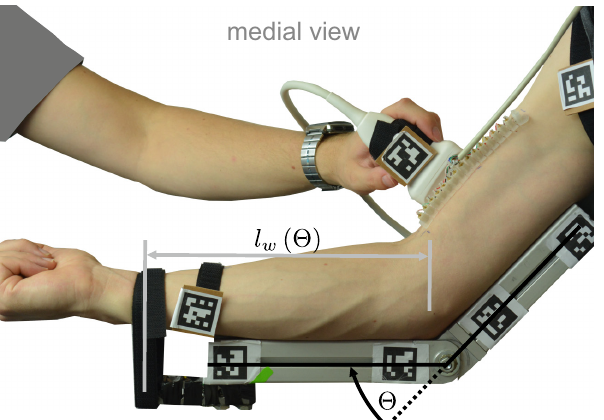
Fig 3. A medial view on the experimental setup. The distance l ( Θ ) between the elbow and the wrist strap, which w mechanically connects wrist and load cell, is marked with gray lines. The distance l w depends on the elbow angle Θ , which is shown in black. A change in joint angle is constrained by the depicted construction of aluminium profiles. If the screw in the hinge joint of the profile structure is loosened, the joint angle can be